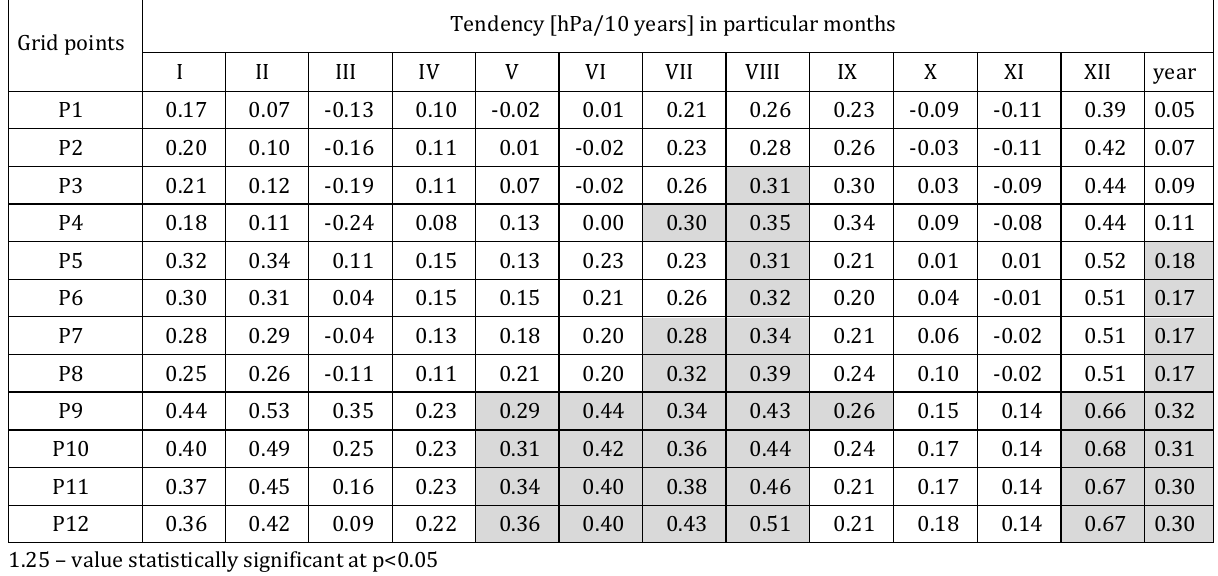
Table 2. Tendency of the air pressure value changes [days/10 years] at selected grid points in the period 1951-2015